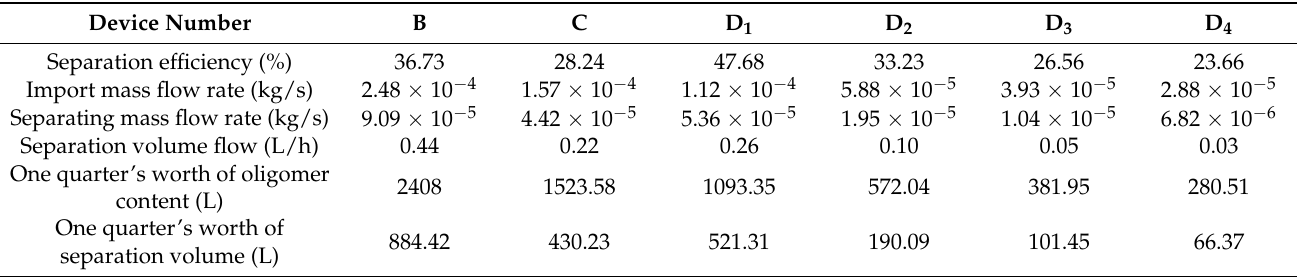
Figure 11. Structure comparison: ( a ) original structure and ( b ) improved structure. Table 12. Separation status after optimization of the high-pressure polyethylene process.